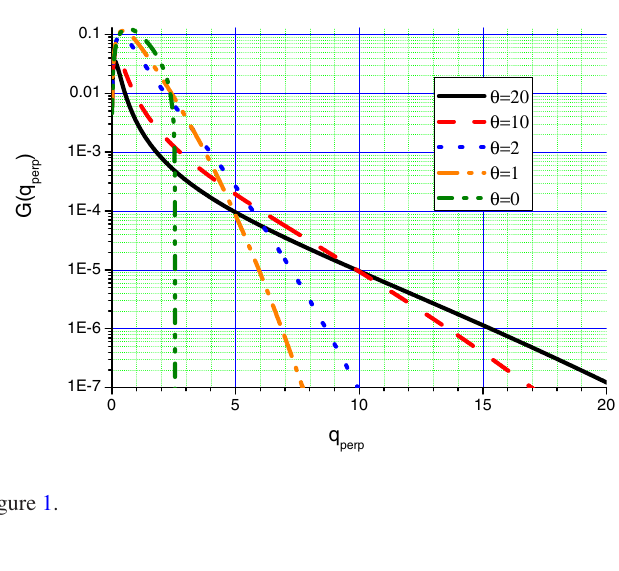
Figure 2. Same as Figure